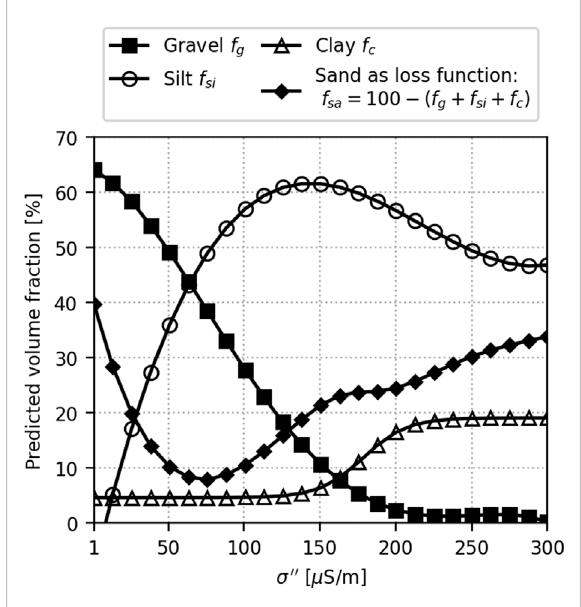
FIGURE 8 Shape of the modelled functions used to predict the different soil fractions for gravel f g , sand f sa , silt f si and clay f c based on their dependence on σ ″